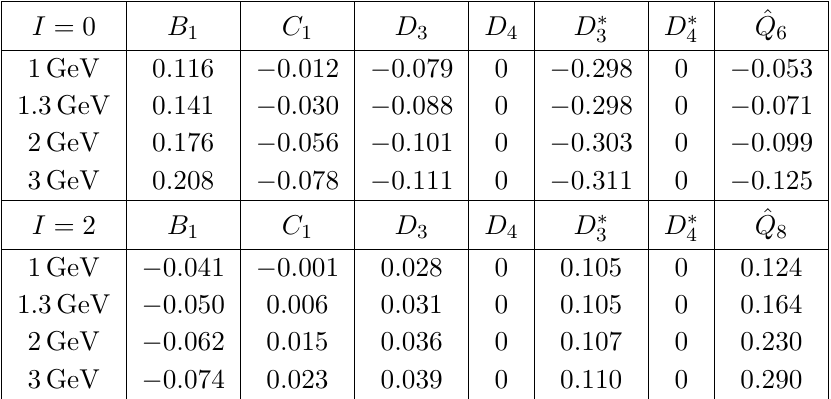
Table 3 . Matrix elements h X i i 0 ; 2 of BSM operators in the DQCD basis allowed by SU(3) but not by SMEFT contributing to the isospin amplitudes A 0 ; 2 in units of GeV 3 for four values of (cid:22) . In the last column we give the values of the matrix elements h ^ Q 6 ( (cid:22) ) i 0 and h ^ Q 8 ( (cid:22) ) i 2 for comparison.